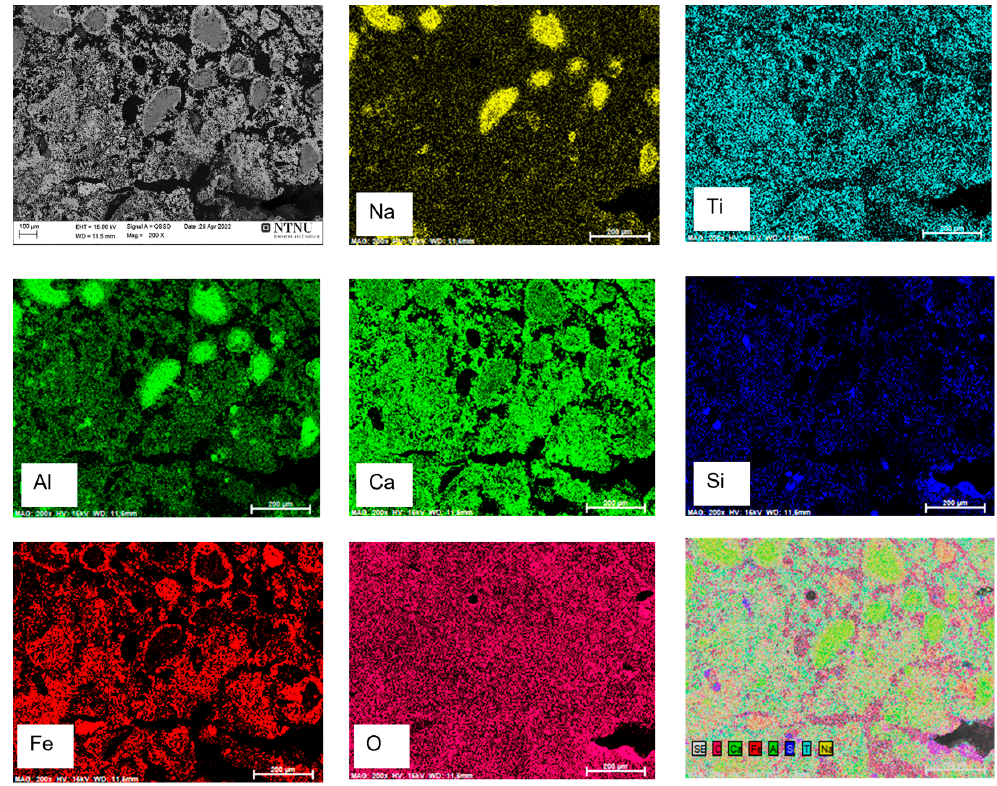
Figure 13. SEM image and EDS analysis of reduced sample